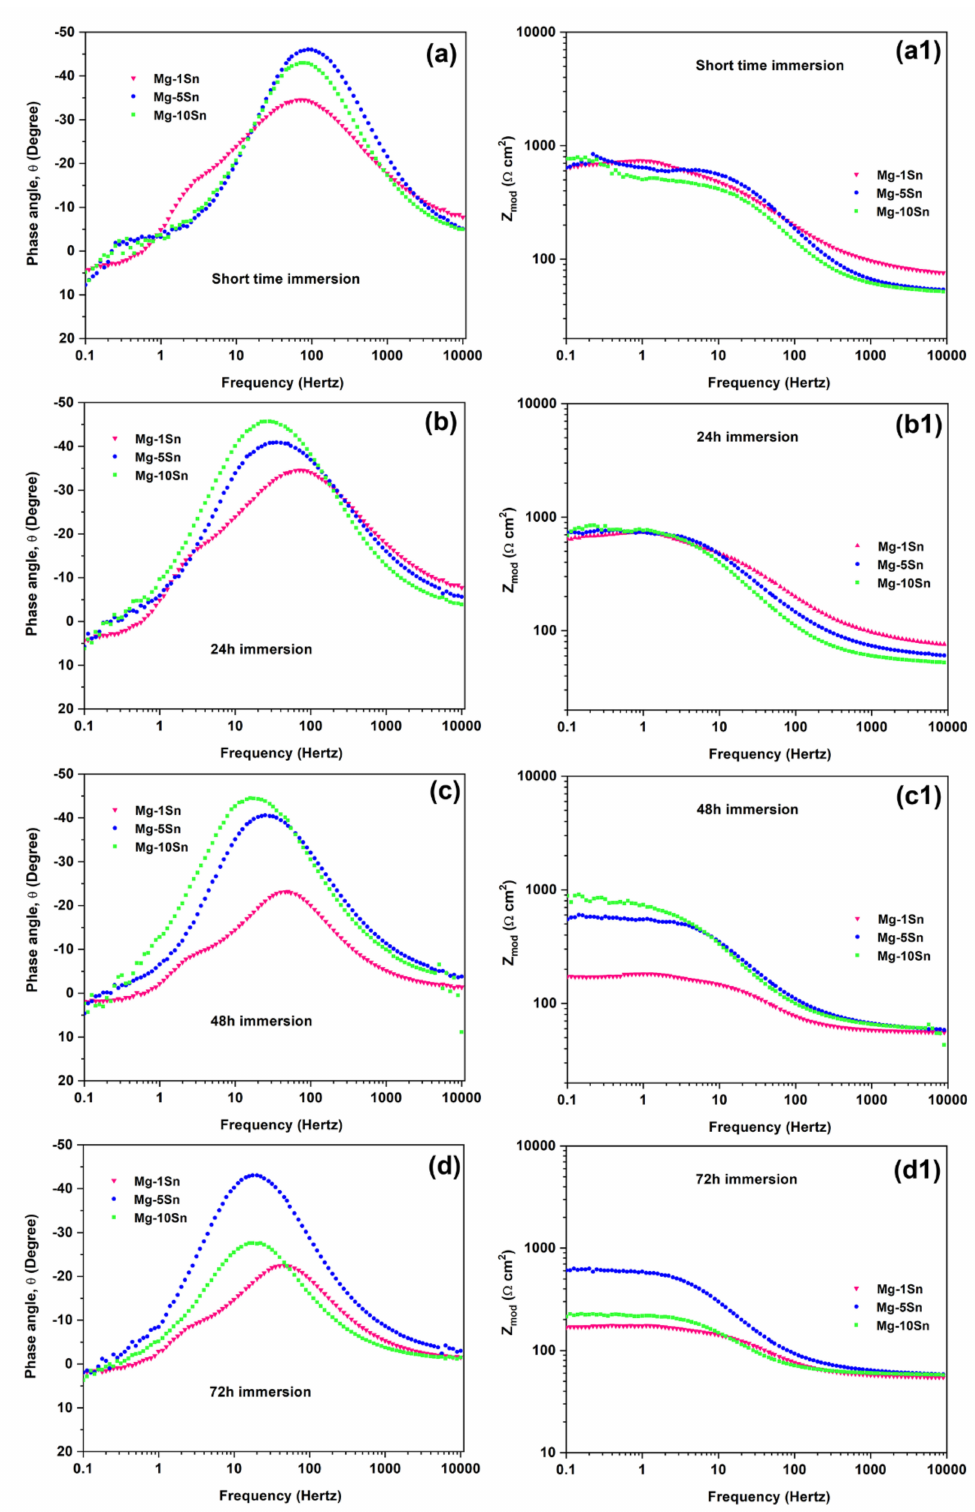
Figure 9. Bode curves ( a – d ) Phase angle ( a1 – d1 ) Impedance curve obtained from EIS test on Mg-Sn alloys for different immersion period ( a , a1 ) Short term ( b , b1 ) 24 h ( c , c1 ) 48 h ( d , d1 ) 72